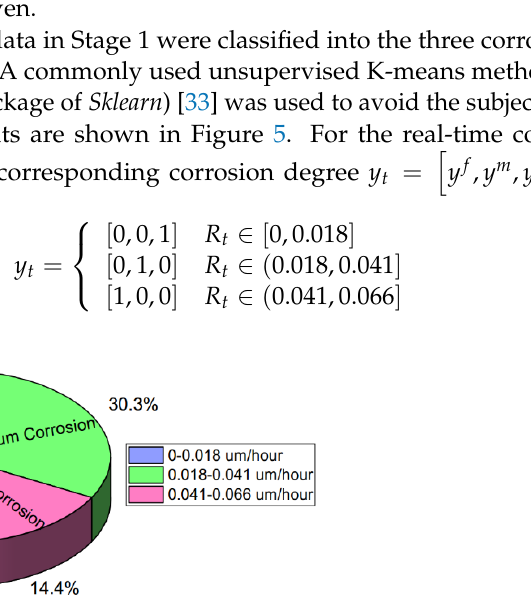
Figure 5. The classification of the corrosion rate on Stage 1.